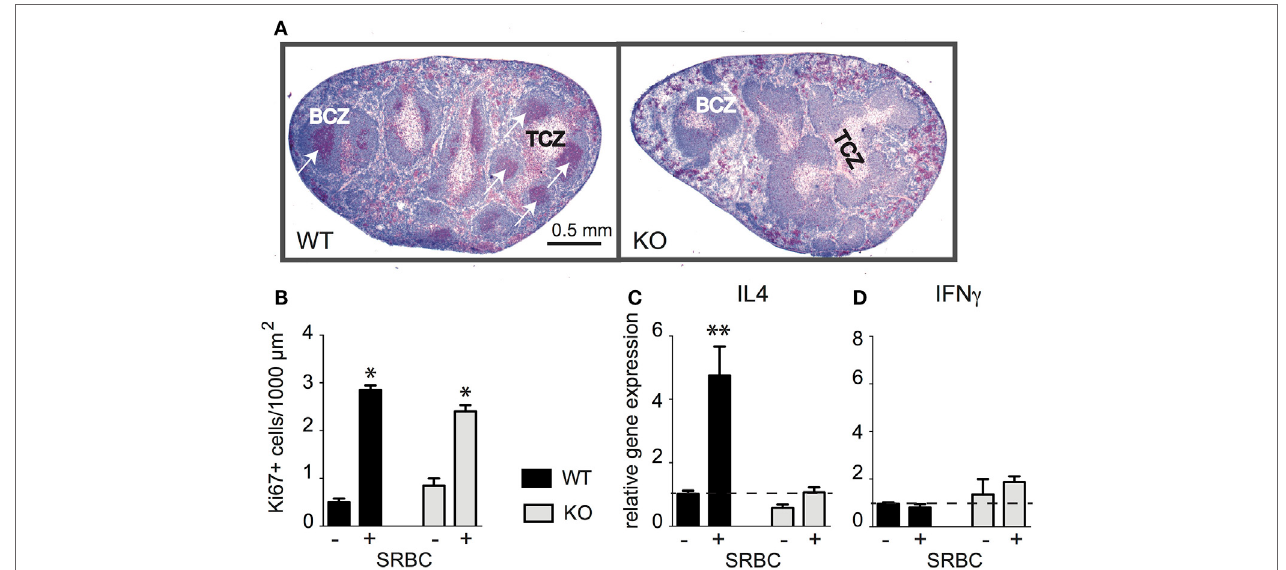
FigUre 1 | CD154 costimulation is essential for the Th2 differentiation of CD4 T cells and the formation of germinal centers (GC) but not for T-cell expansion. Wild-type (WT) and CD154-deficient (KO) mice were primed with 10 9 sheep red blood cell (SRBC) intravenously. Splenic sections were stained for B cells (blue, B220) and proliferating cells (red, Ki-67 + ). (a) Proliferating cells in spleens from WT and CD154-deficient mice 10 days after injection of SRBC are shown. White arrows indicate GC in WT mice. (B) Proliferating cells (red, Ki-67 + ) were counted within the T-cell zones (TCZ) before and 3 days after injection of SRBC [*significant differences between the number of proliferating T cells compared to unchallenged mice; mean ± SEM (Kruskal–Wallis test), n = 3, p < 0.05]. (c,D) mRNA expression of IL-4 and IFN γ was analyzed by real-time RT-PCR and normalized to the housekeeping gene MLN51 before and 3 days after challenge with SRBC and displayed as x -fold increase compared to control spleens from non-injected mice. Dotted lines mark mean expression levels of controls [data show mean ± SEM (Kruskal–Wallis test), n = 6–7, ** p <